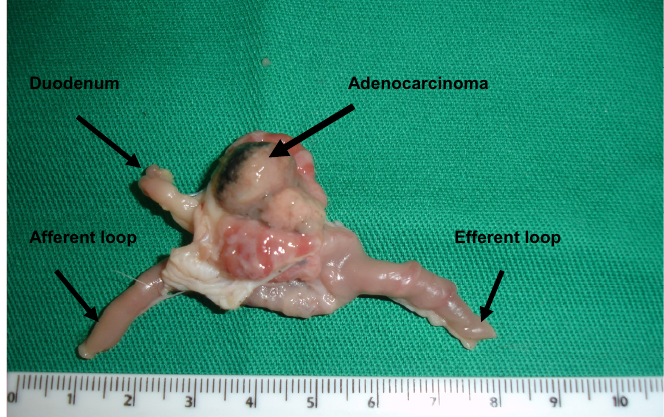
FIGURE 1 – Photograph of a stomach with adenocarcinoma